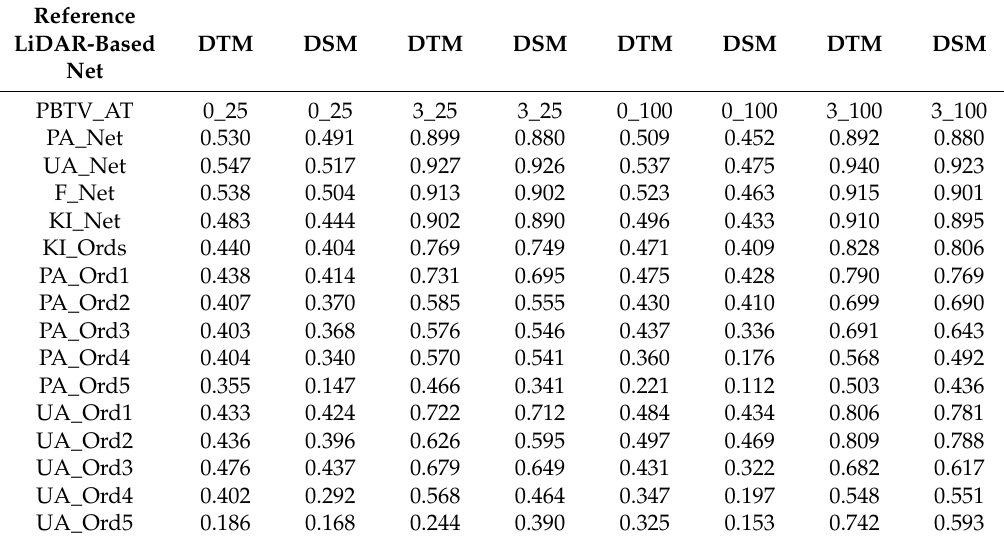
Performance accuracy metrics computed based on a comparison between whole networks/orders extracted from the LiDAR DTM/DSM 28.5 m and the PALSAR DEM 28.5 m at different ATs expressed in the corresponding number of pixels and PBTV in pixels.